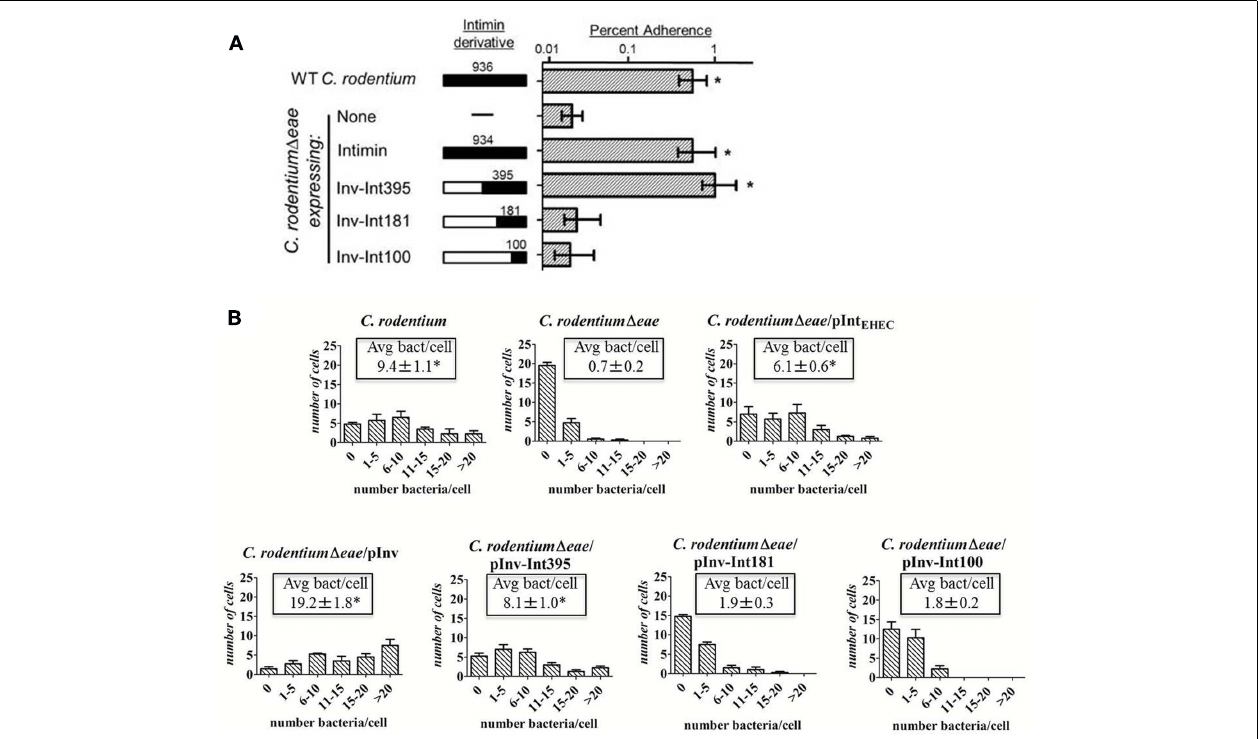
( p < 0.05) higher than C. rodentium Δ eae of C. rodentium Δ eae expressing pInv–Int181 or pInv–Int100, determined by two-tailed unpaired t -test. (B) Mouse embryonic fibroblasts were infected with the indicated C. rodentium strains and the number of bound bacteria per cell was counted for four sets of 25 randomly selected cells. Shown are the number of cells with the given number (0, 1–5, 6–10, 11–15, 16–20, and > 20) of bound bacteria.The experiment was performed in triplicate. Shown in box is the mean number of bacteria per cell ± SEM. Asterisk indicates a significant difference ( p < 0.05) compared to C. rodentium Δ eae , determined using a one-way ANOVA